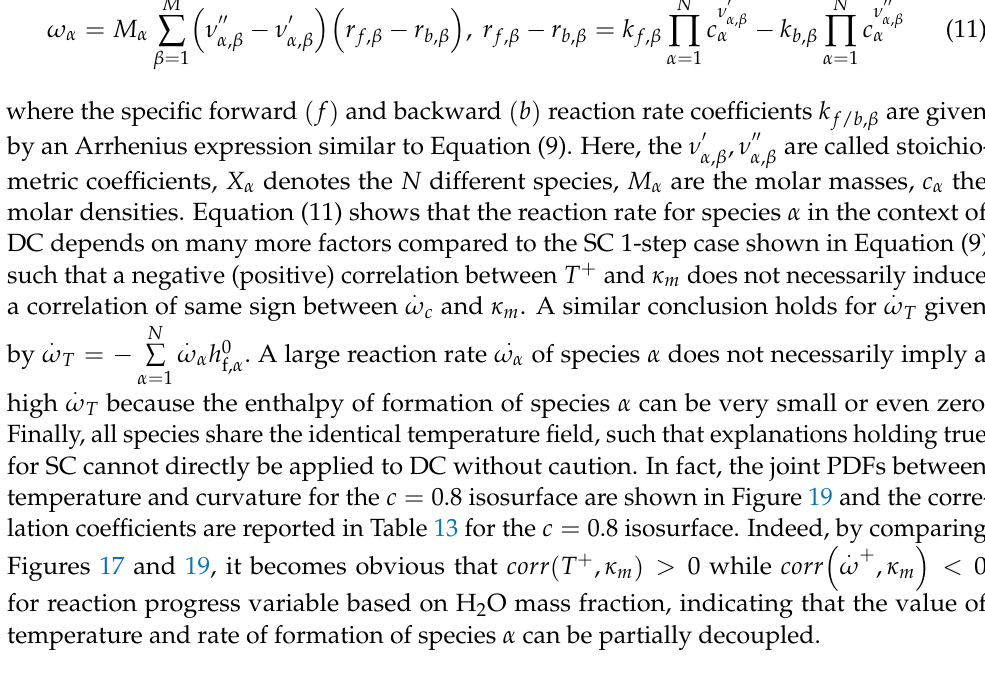
Table 13. Correlation coefficients between T + and κ m for the c = 0.8 isosurface value for all